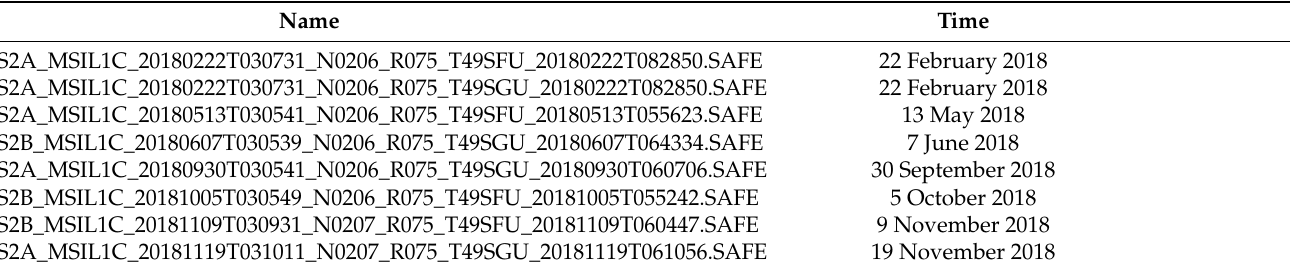
Table 1. Remote-sensing image data